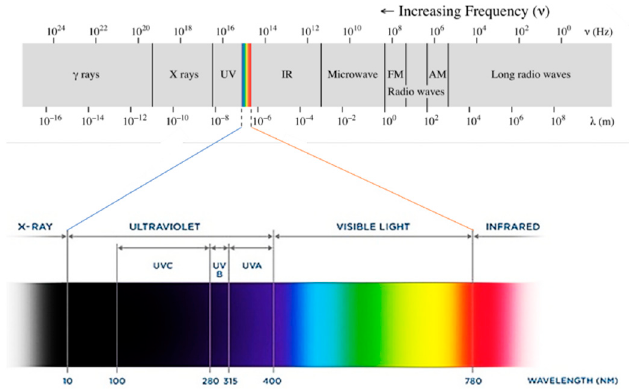
Figure 4. Electromagnetic radiation spectrum.